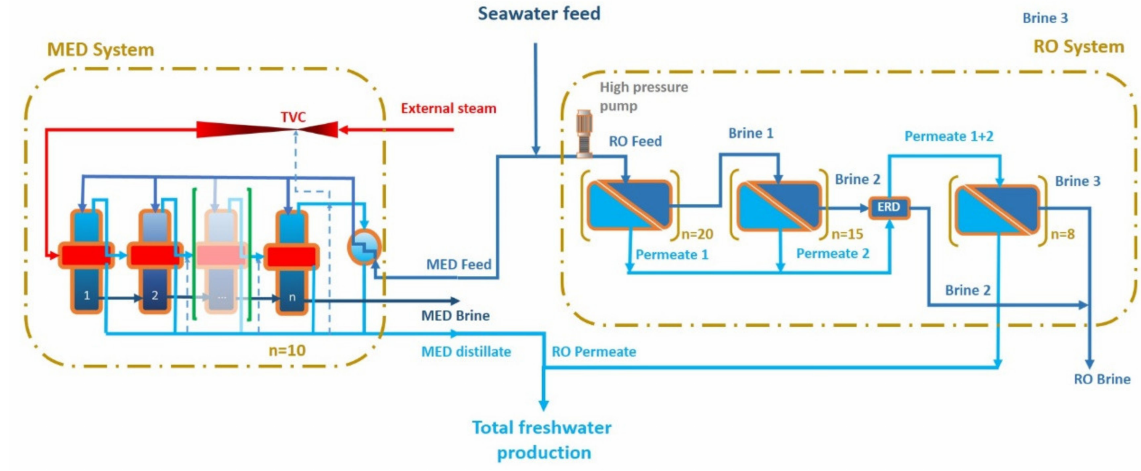
Figure 7. Diagram of MED-TVC-RO simple hybrid system with ERD unit proposed by Al-hotmani et al.